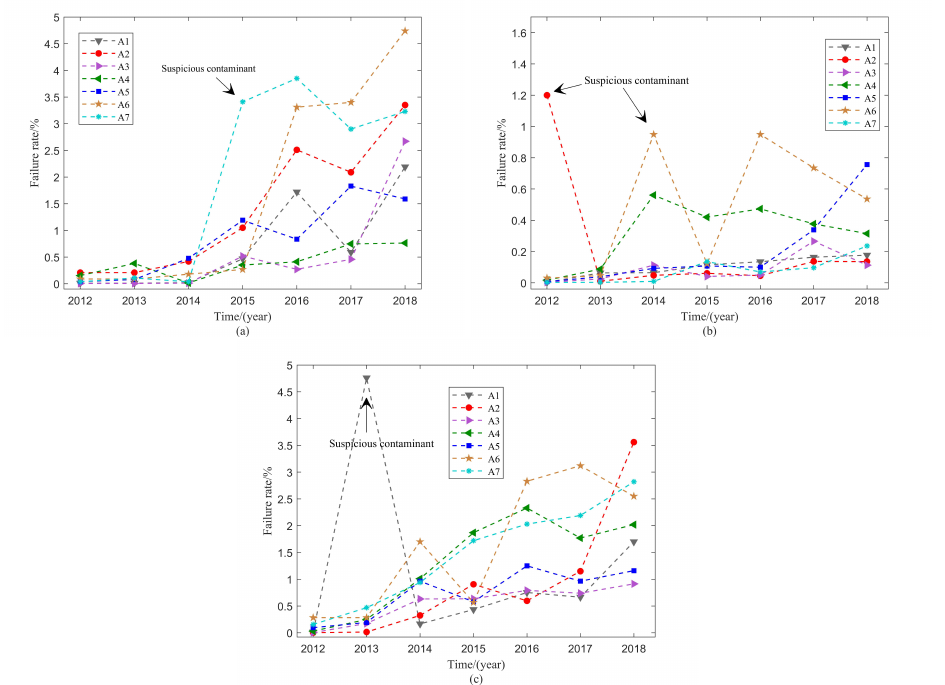
Figure 2. The raw failure rate data of electrical meters from ( a ) XZ, ( b ) XJ, and ( c )